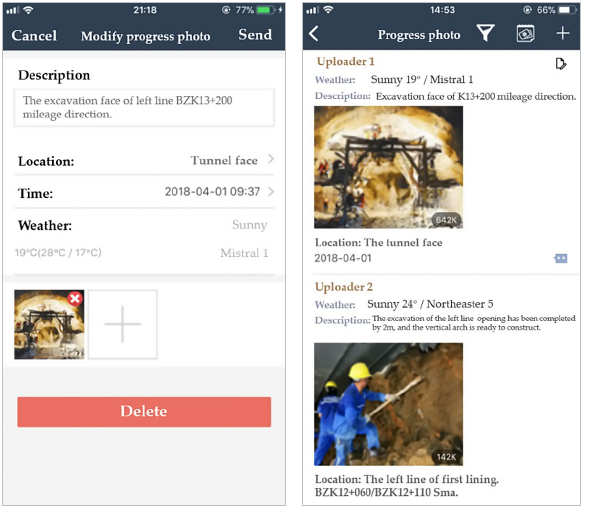
Figure 13. The real time process of construction is shown on the mobile